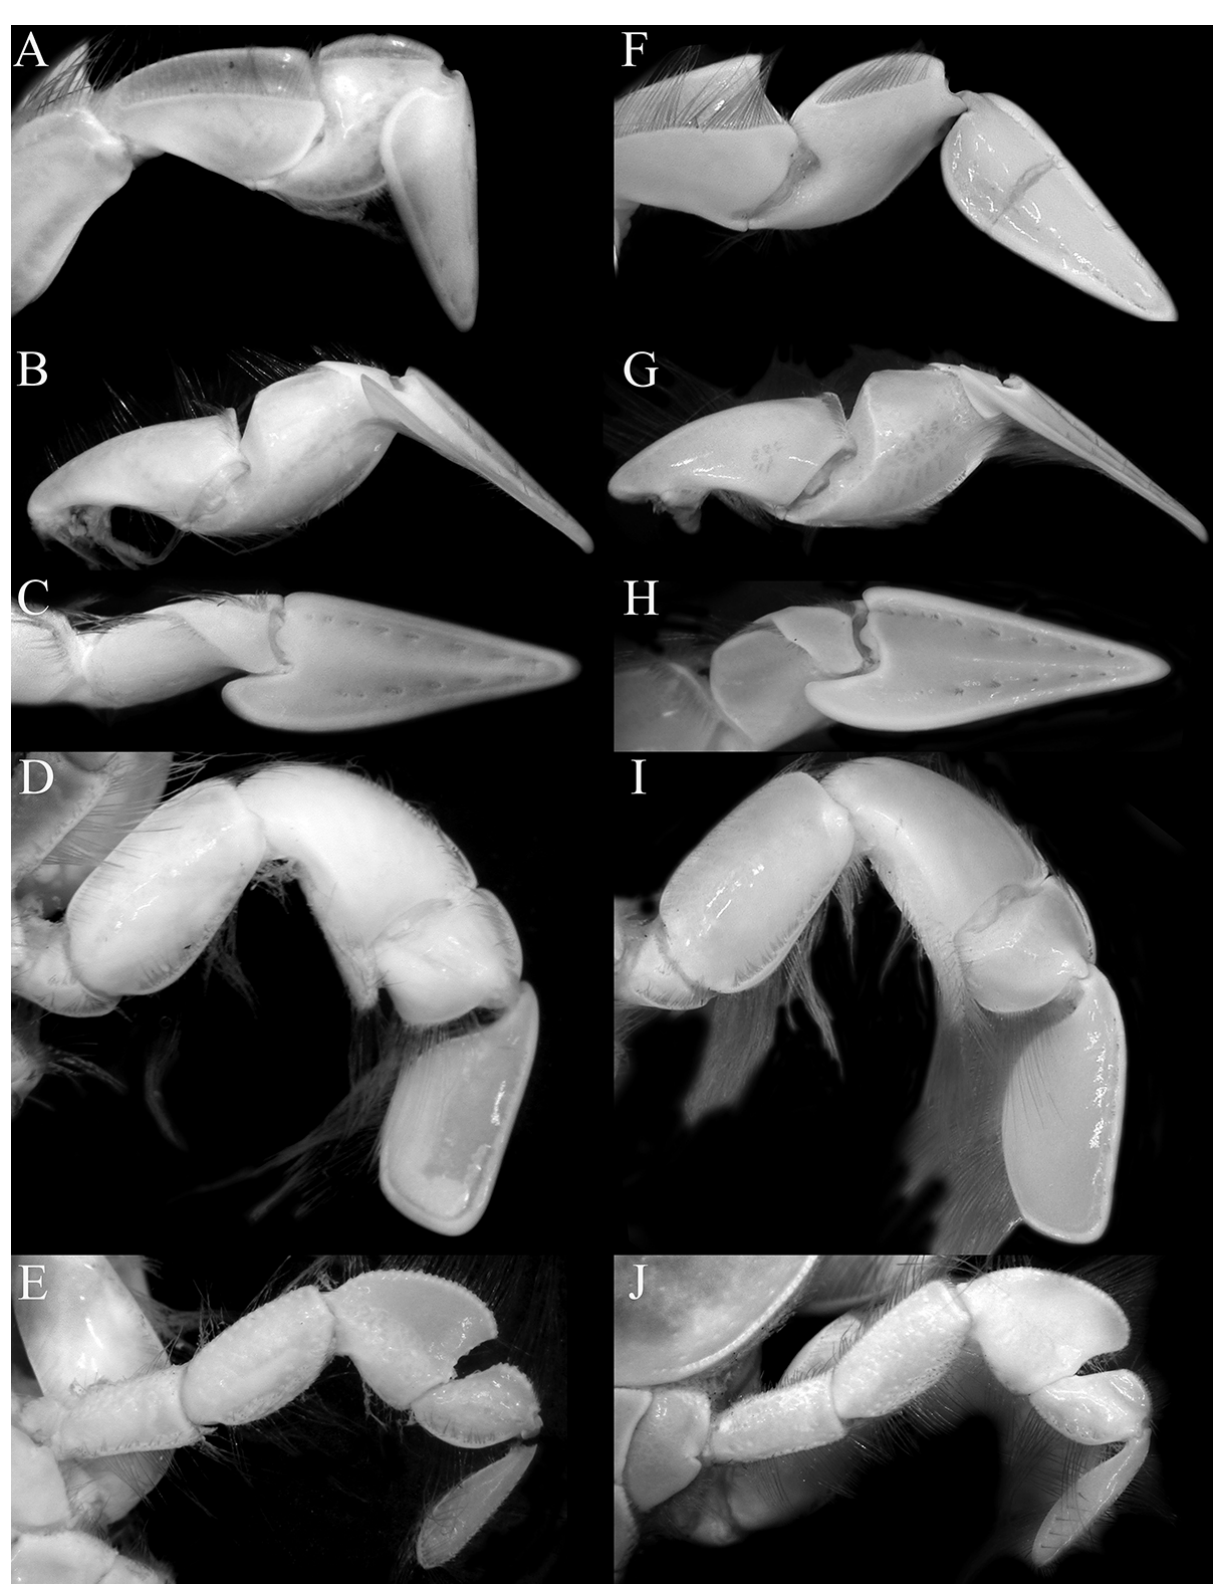
Figure 4. A–E, Umalia trirufomaculata , male (11.8 x 15.6 mm) (ZSI), Andamans; F–J, U. misakiensis , male (16.0 x 21.8 mm) (ZRC 2001.0637), Philippines. A, F, carpus, propodus and dactylus of first ambulatory leg; B, G, carpus, propodus and dactylus of second ambulatory leg; C, H, marginal view of dactylus of second ambulatory leg; D, I, right third ambulatory leg; E, F, right fourth ambulatory